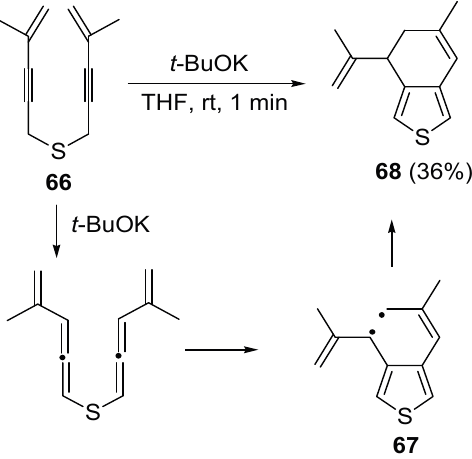
Scheme 25. Synthesis of β -allyl thiophene derivatives 73 by base-promoted